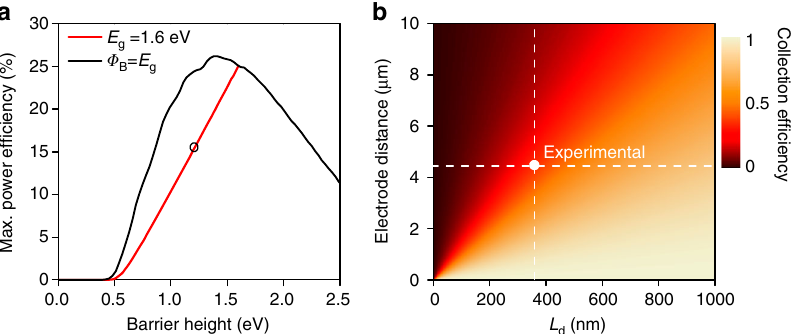
Fig. 5 Modelling of theoretical power conversion ef fi ciency limit and collection ef fi ciency. a Theoretical power conversion ef fi ciency limit ( red ) as a function of barrier height Φ B , calculated for a Schottky junction MAPbI 3 back-contact perovskite solar cells (bc-PSCs) under AM1.5G irradiation, according to Pulfrey et al. 29 . The temperature of the device was assumed to be T = 300K, the effective Richardson constant (thermionic emission) A** = 120 Acm − 2 K − 2 . The black curve shows the maximum power conversion ef fi ciency for the ideal situation in which the barrier height is equal to the band-gap. The black circle indicates the maximum theoretical PCE achievable for a 4-methoxythiophenol (OMeTP) and 4-chlorothiophenol (ClTP) modi fi ed “ a ” -MAPbI 3 - “ b ” bc-PSC. b Contour map of charge collection ef fi ciency as a function of diffusion length L d and electrode separation distance. The dashed lines indicate the current experimental device